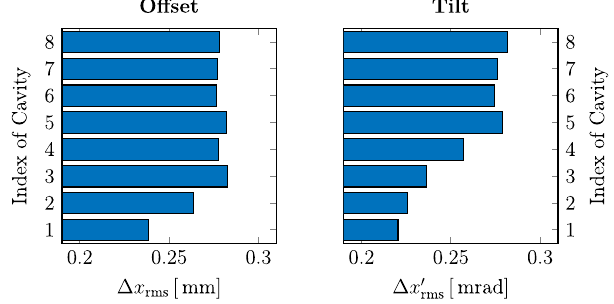
FIG. 9. Rms error between the fitted and the simulated misalignments of 8 cavities in the injector module. 28 exper- imentally derived rf data sets are used. No module misalignments or BPM errors are considered. The parameter range of the misalignments is set accordingly to the design values Δ u cav ¼ 0 . 5 mm and Δ u 0 0 . 5 cav ¼